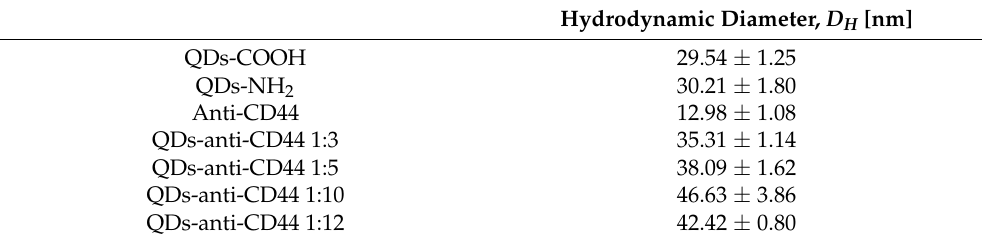
Figure 2. SEM images of ( A ) QDs-COOH and ( B ) QDs-NH 2 . Table 1. Hydrodynamic diameter of unmodified and modified QDs measured using DLS.